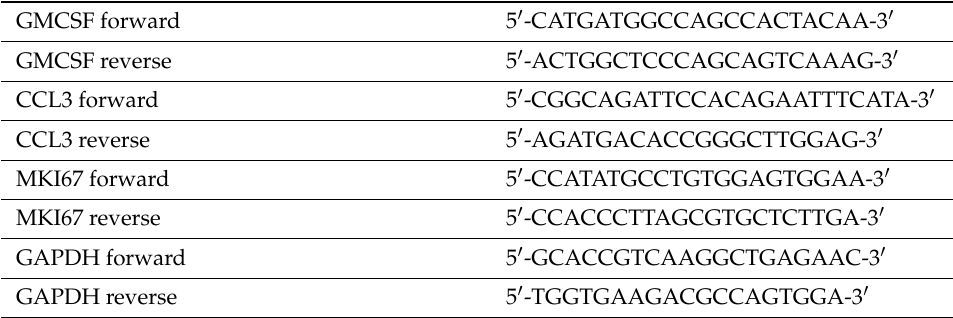
Table 1. SYBR Green primers used for real-time